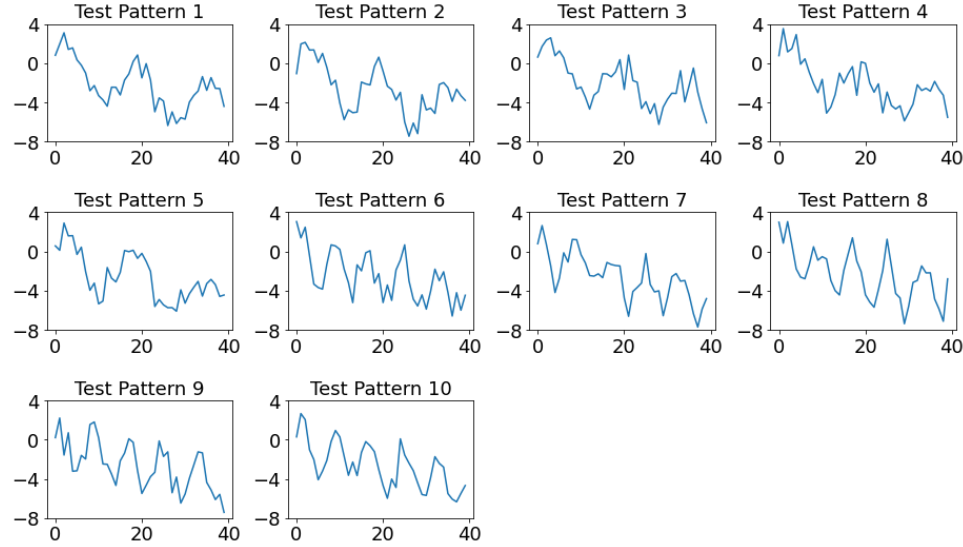
Figure 9. Test patterns for experiment 2.